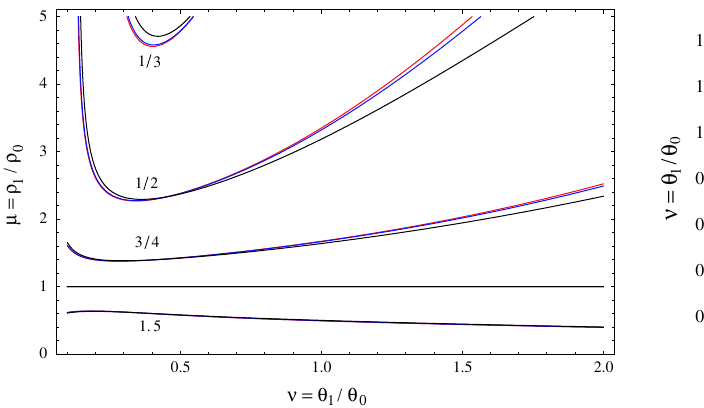
FIG. 3. (Color) Contours of c ¼ Tr ð AB þ Þ = j A j in blue with black ffiffiffiffiffiffiffi p ffiffiffiffi = (cid:11) 3 j A j labels and 2 p in red for sandwich 4 15